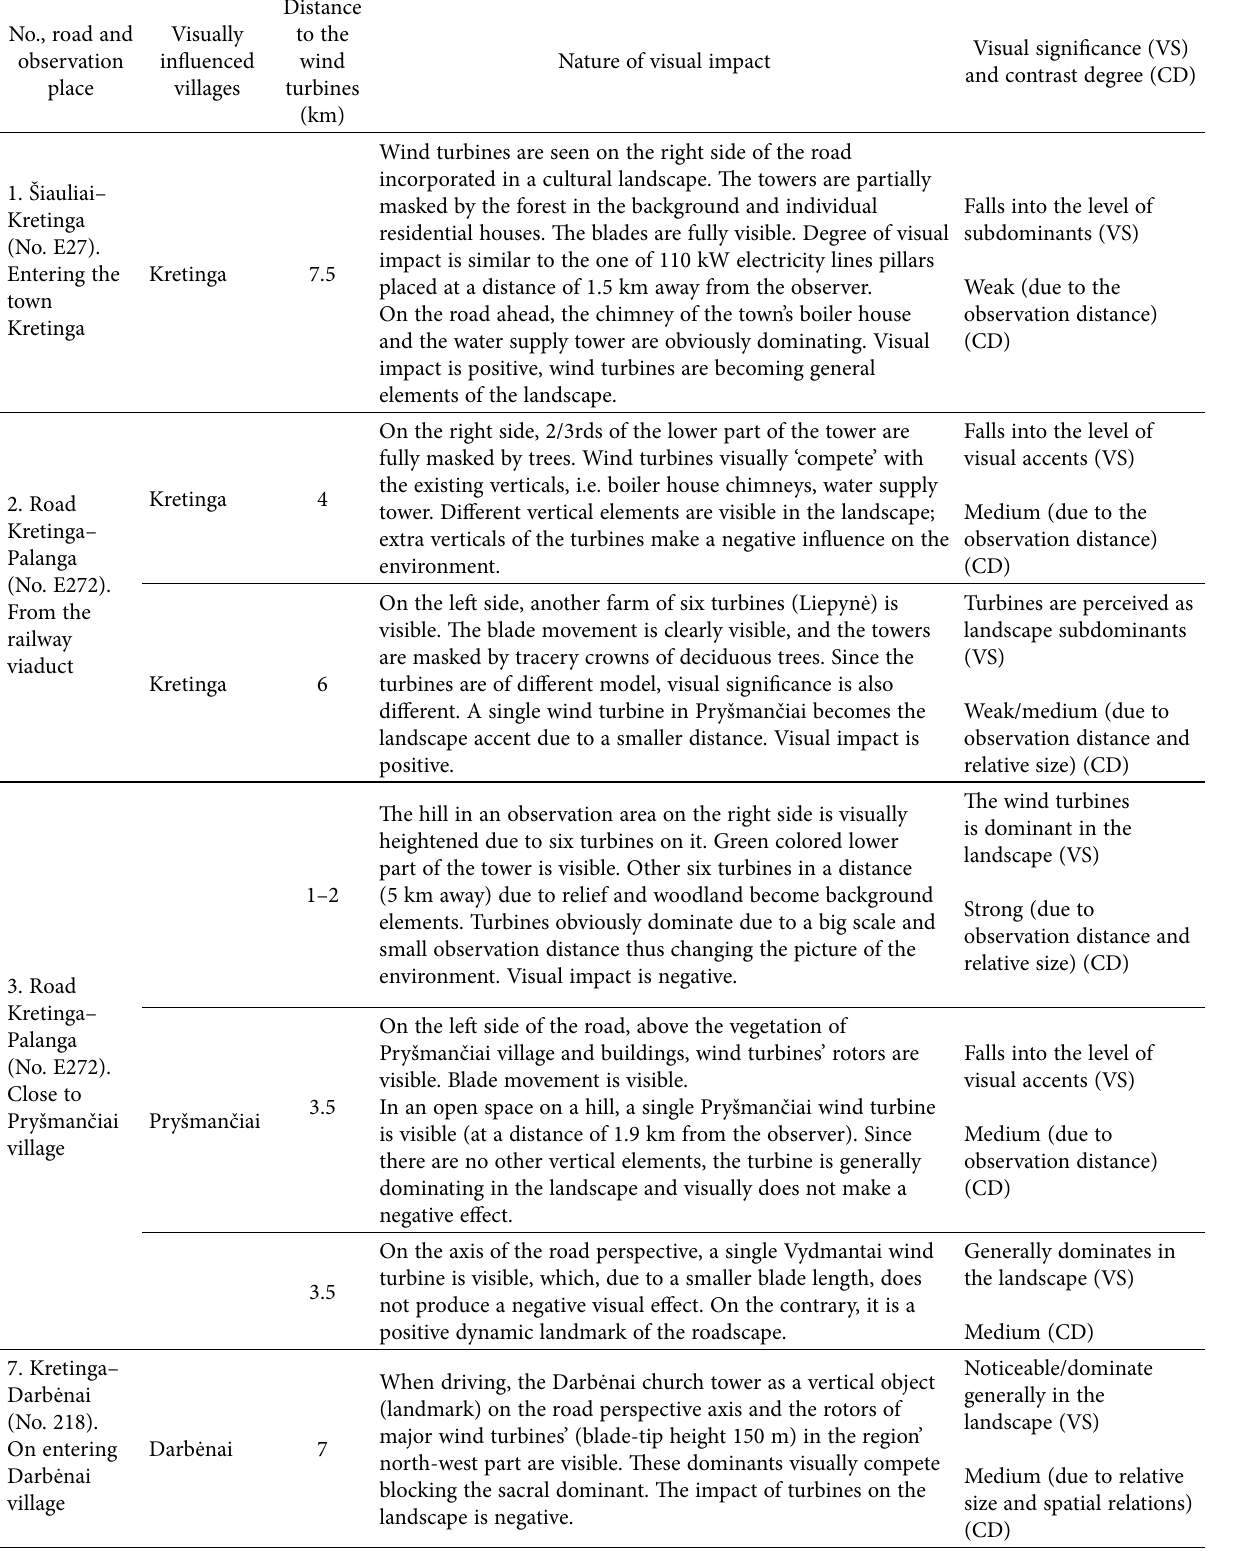
Table 2. Assessment of the significance of visual impact of wind turbines and the degree of contrast as well as the nature of the impact from the observation places (due to a large scope of study, the assessment results in the paper are presented from six observation places